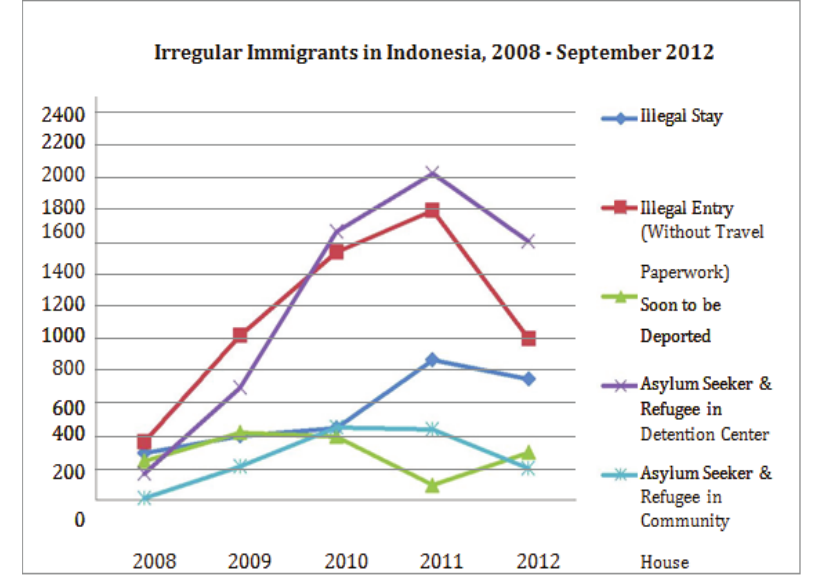
figure 1: Irregular immigrants in Indonesia, 2008-september 2012